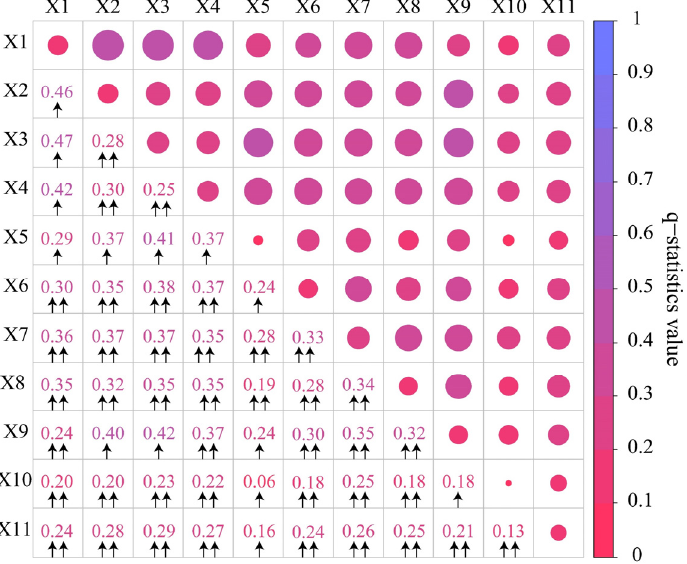
Figure 12. The interaction effects among environmental factors (X1–X11) on NDVI change. Note: bivariate-enhanced (“ ↑↑ ”) and nonlinear-enhanced (“ ↑ ”) relationships, respectively, between the two factors.